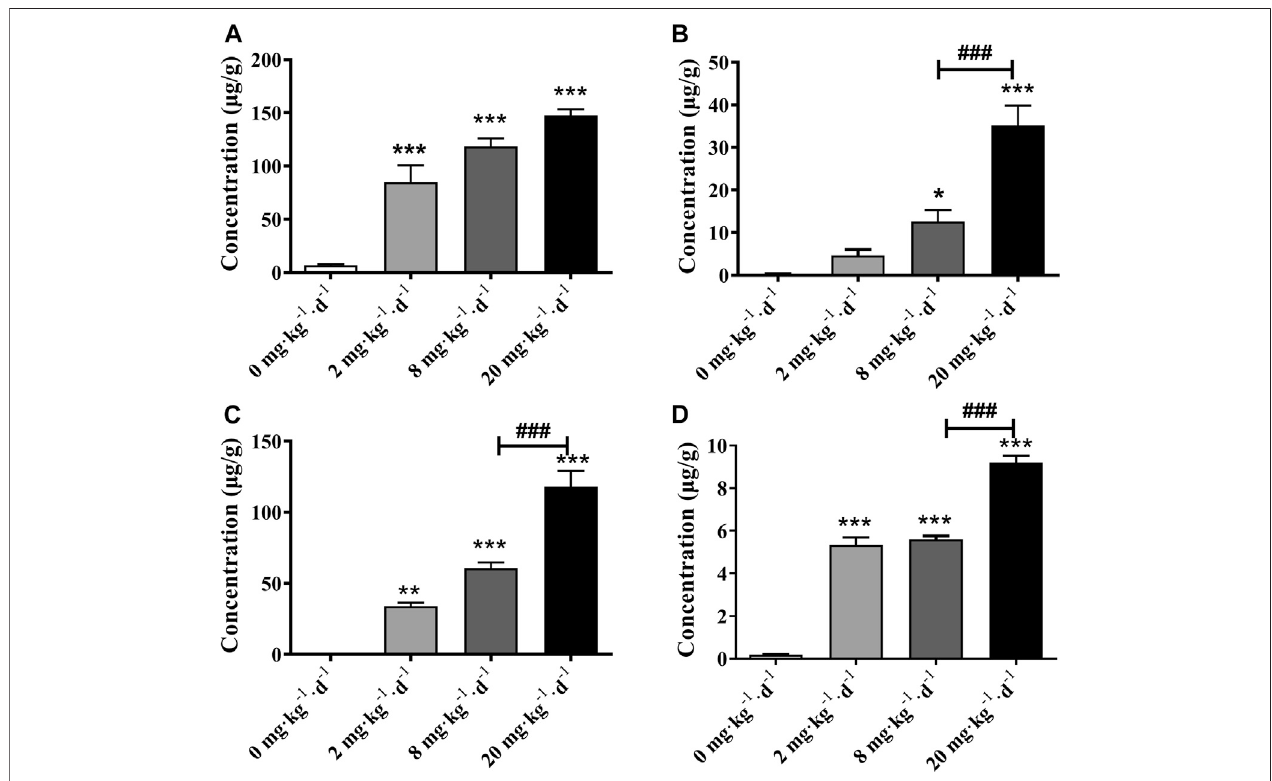
FIGURE5| Totalarsenicconcentrationinrattissuesfollowing28 daysintragastricadministrationofdifferentdosesofATO.Totalarsenicconcentrationintheblood (A) ,liver (B) ,kidney (C) ,heart (D) .Asterisksindicate statisticaldifferencescompared tothecontrolgroup(0 mg kg − 1 d − 1 )at p < 0.05(*); p < 0.01(**); p < 0.001(***). ### : statistical difference compared to the 8 mg kg − 1 d − 1 group ( p < 0.001).